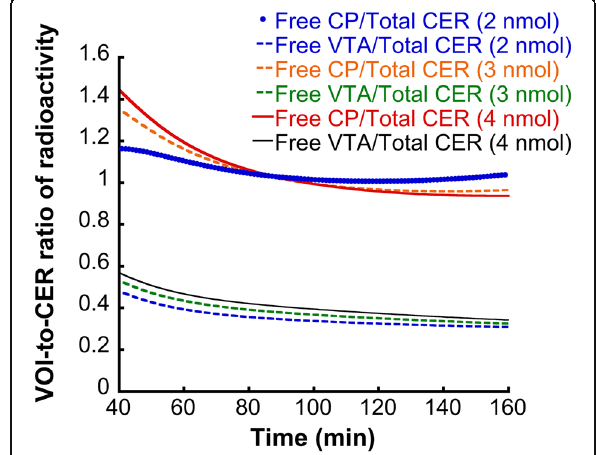
Fig. 3 The ratio of radioactivity in the CP (a high-binding VOI) or VTA (a low-binding VOI) to the radioactivity in the Cer (the reference region), as estimated on the basis of a simulated partial saturation experiment, for various masses of injected unlabeled ligand. At time- points beyond 70-min post radiotracer injection, this ratio is around 1 in the CP and 0.4 in the VTA. This ratio is relatively temporally stable at the time points employed in the Scatchard plot quantification with the partial saturation approach